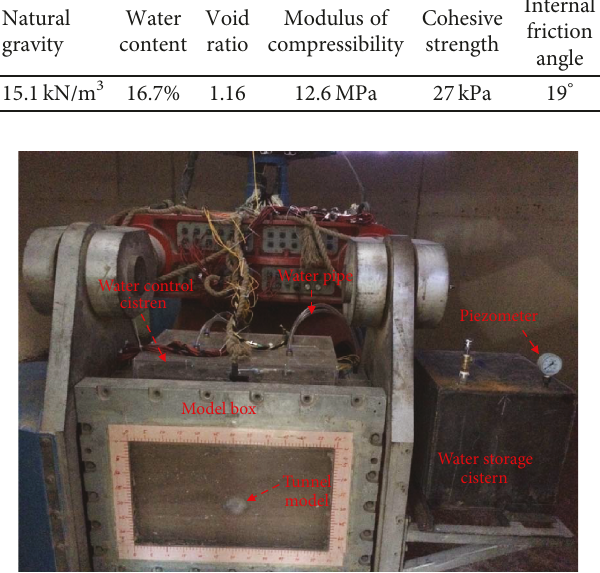
Figure 6: Model installation. Table 2: Centrifugal scaling laws.